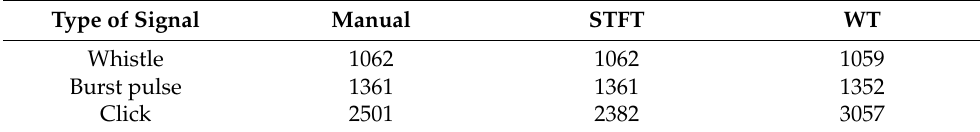
Table 5. Results of target signal detection obtained using different methods. Type of